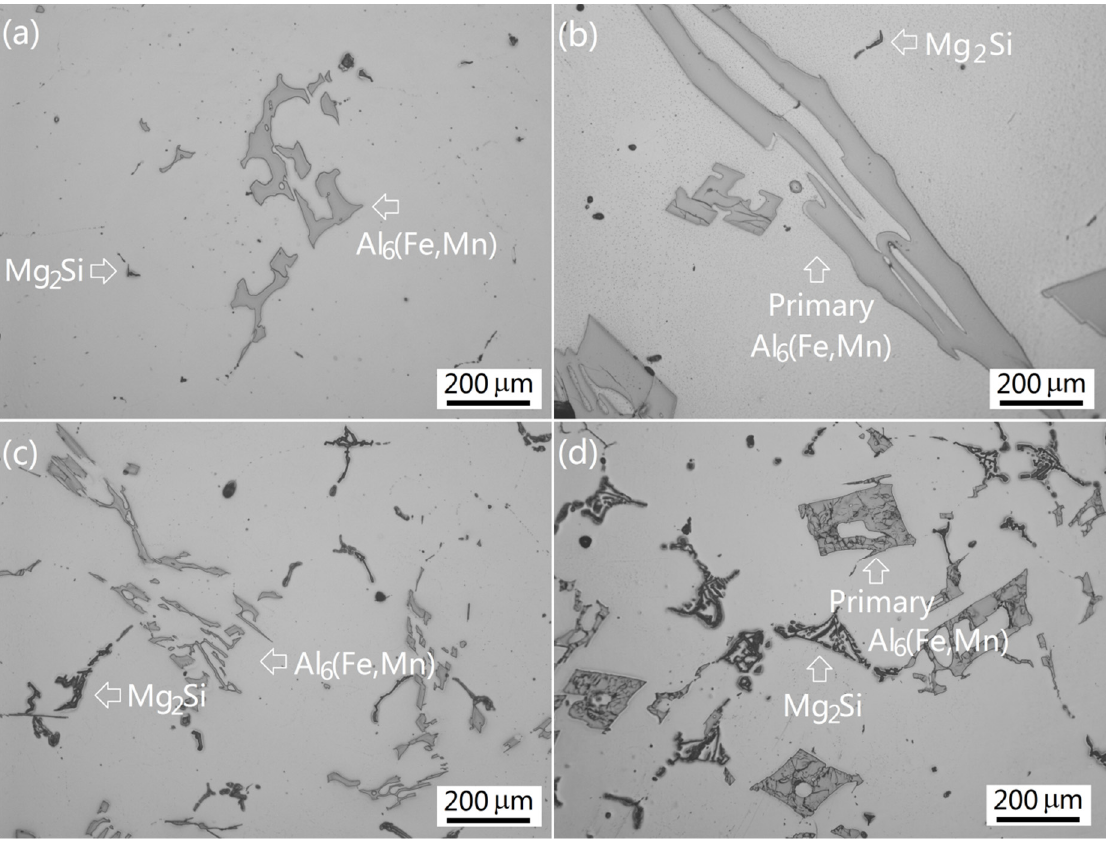
Figure 7. The as ‐ cast microstructures of the alloys solidified under slow cooling ( a ) Alloy I ‐ 4; Figure 7. The as-cast microstructures of the alloys solidified under slow cooling ( a ) Alloy I-4; ( b ) Alloy ( b ) Alloy I ‐ 5; ( c ) Alloy II ‐ 1; ( d ) Alloy II ‐ 4. I-5; ( c ) Alloy II-1; ( d ) Alloy